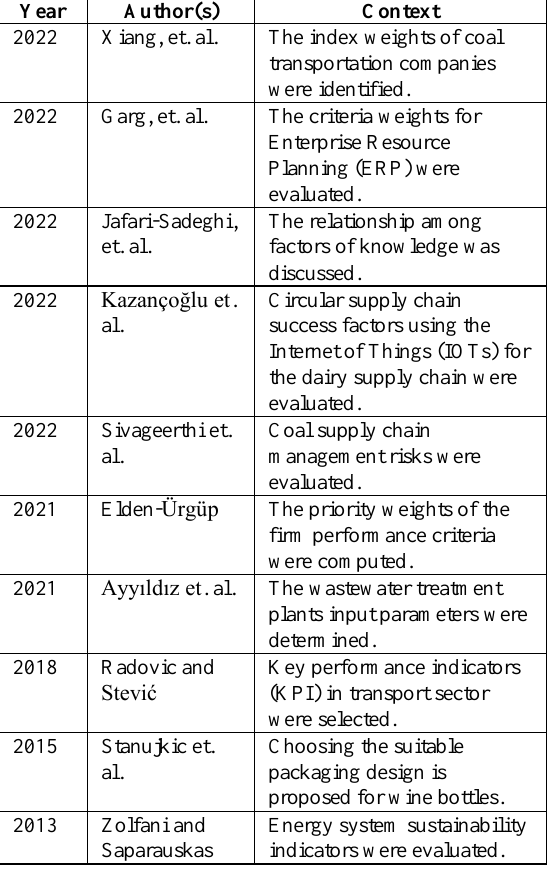
Table 2: Researches Using SWARA Method